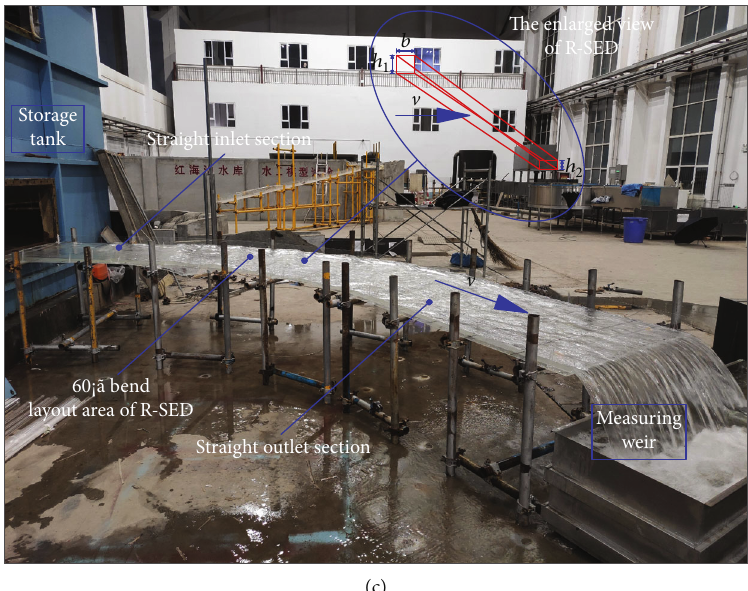
Figure 1: (a) Plane layout of experimental setup and setting of measurement cross-sections; (b) three-dimensional structure of the spillway; (c) photo of the physical